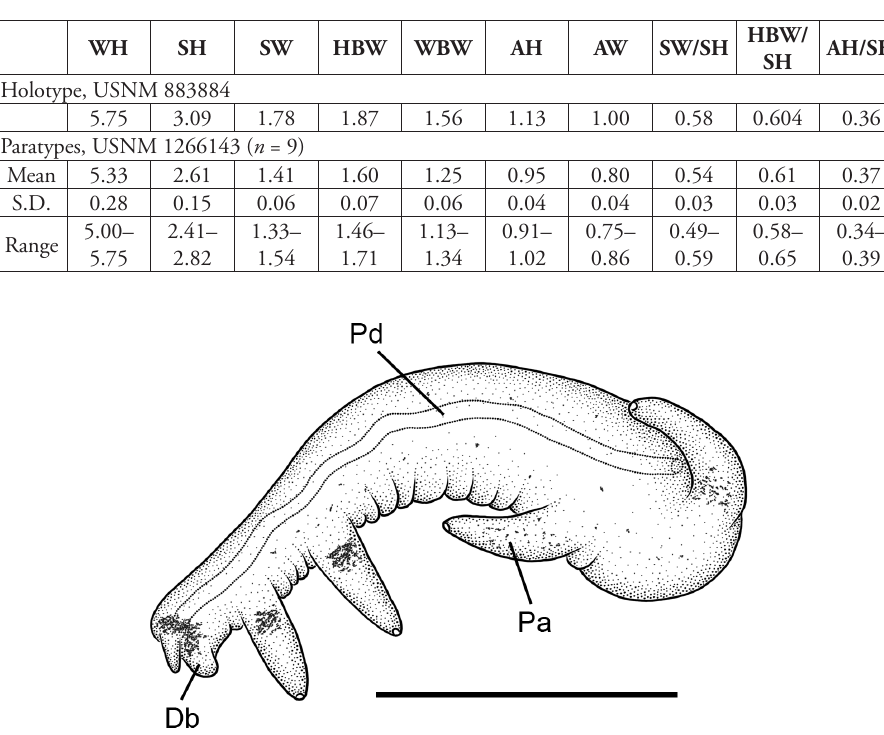
Table 1. Shell parameters for Tryonia infernalis . Measurements are in mm.